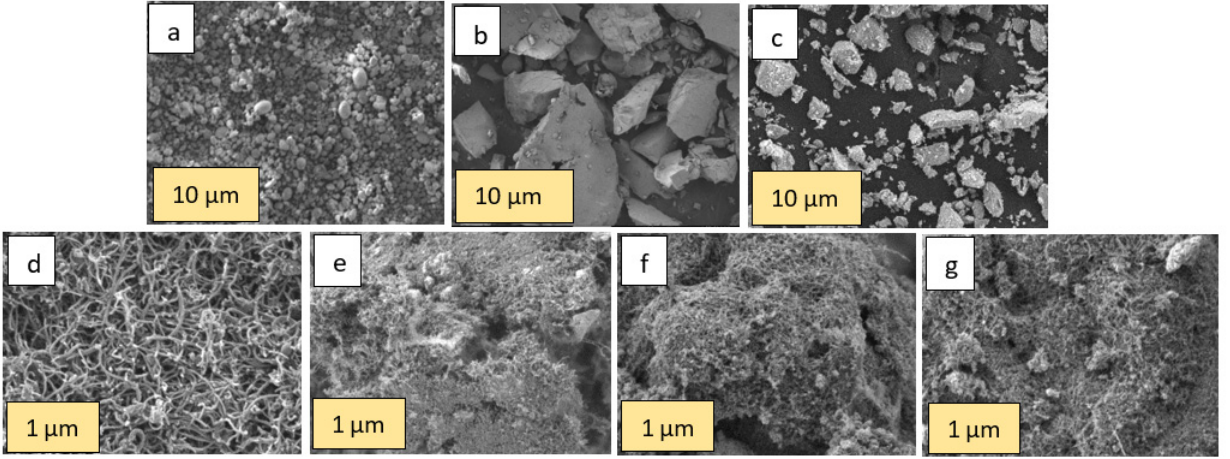
Figure 1. SEM image of ( a ) Ni(OH) 2 ; ( b ) Fe 2 O 3 ; ( c ) MnO 2 ; ( d ) CNTs; ( e ) Ni(OH) 2 -CNT; ( f ) Fe 2 O 3 -CNT; and ( g ) MnO 2 -CNT.